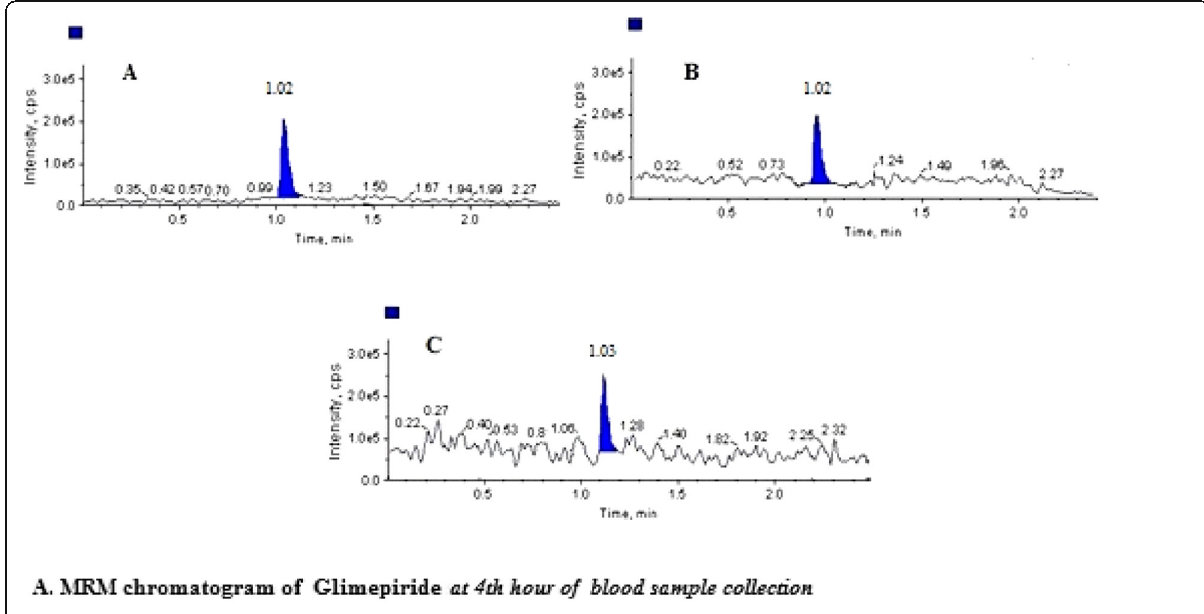
Fig. 4 MRM chromatogram of glimepiride form extracted rat plasma samples at 4th hour alone ( a ), glimepiride with C. frutescens 1st day interaction ( b ), glimepiride with C. frutescens 15th day interaction ( c